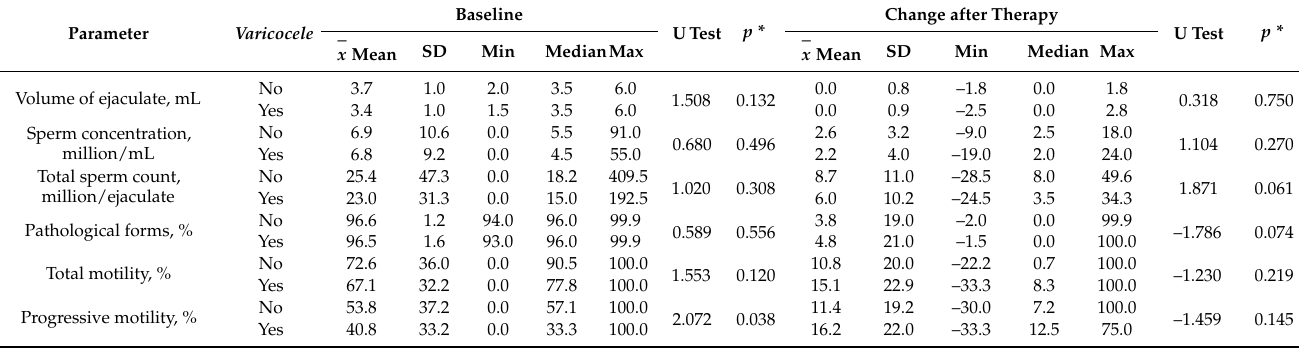
Table 5. Effects of treatment on general sperm parameters in relation to the presence of varicocele .